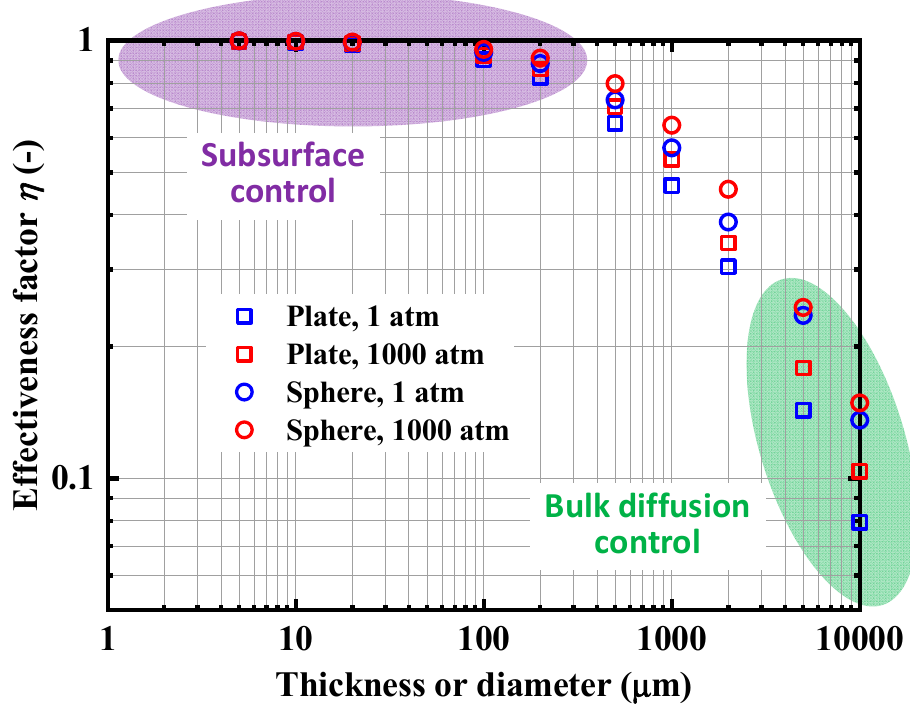
Figure 15. Calculated η values for Pd plates and spherical particles of various thicknesses and diameters, respectively, under constant hydrogen pressure of 1 and 1000 atm at 25 ◦.